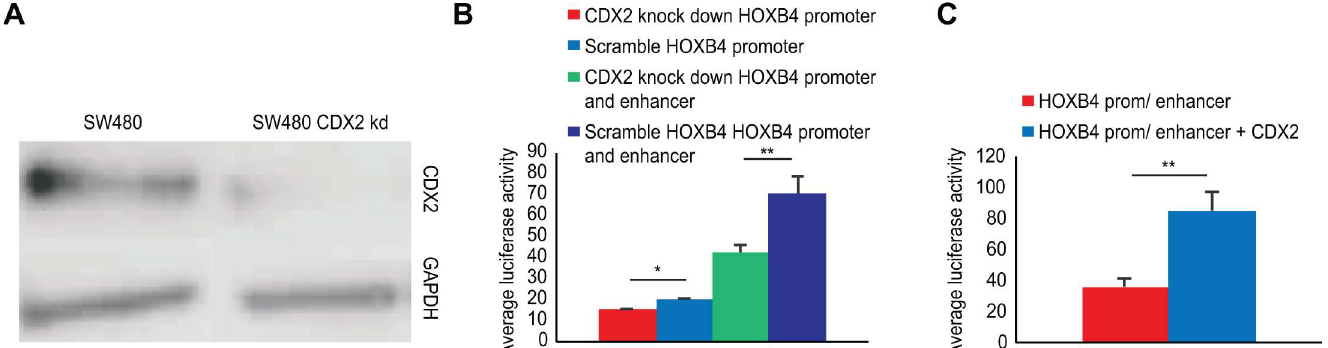
Fig 2. The effects of CDX2 knock down and overexpression on HOXB4 expression in the SW480 cell line and functional analysis of 4 different CDX2 binding sites in the HOXB4 enhancer region. Fig 2A) Western blot analysis of CDX2 expression levels in SW480 cells treated with scrambled shRNA and cells in which CDX2 was knocked down. GADPH was used as a control to analyze equal amounts of total cellular protein. Fig 2B) The effects of CDX2 knock down on the promoter activities of reporter constructs containing the HOXB4 promoter alone or the HOXB4 promoter includingthe enhancer region. Fig 2C) Transient transfection of the HOXB4 promoter and enhancer reporter construct in SW480 cells with and without co-transfection of a CDX2 expression plasmid. The mean (n = 4) and SD are shown. * P < 0.05 and ** P <